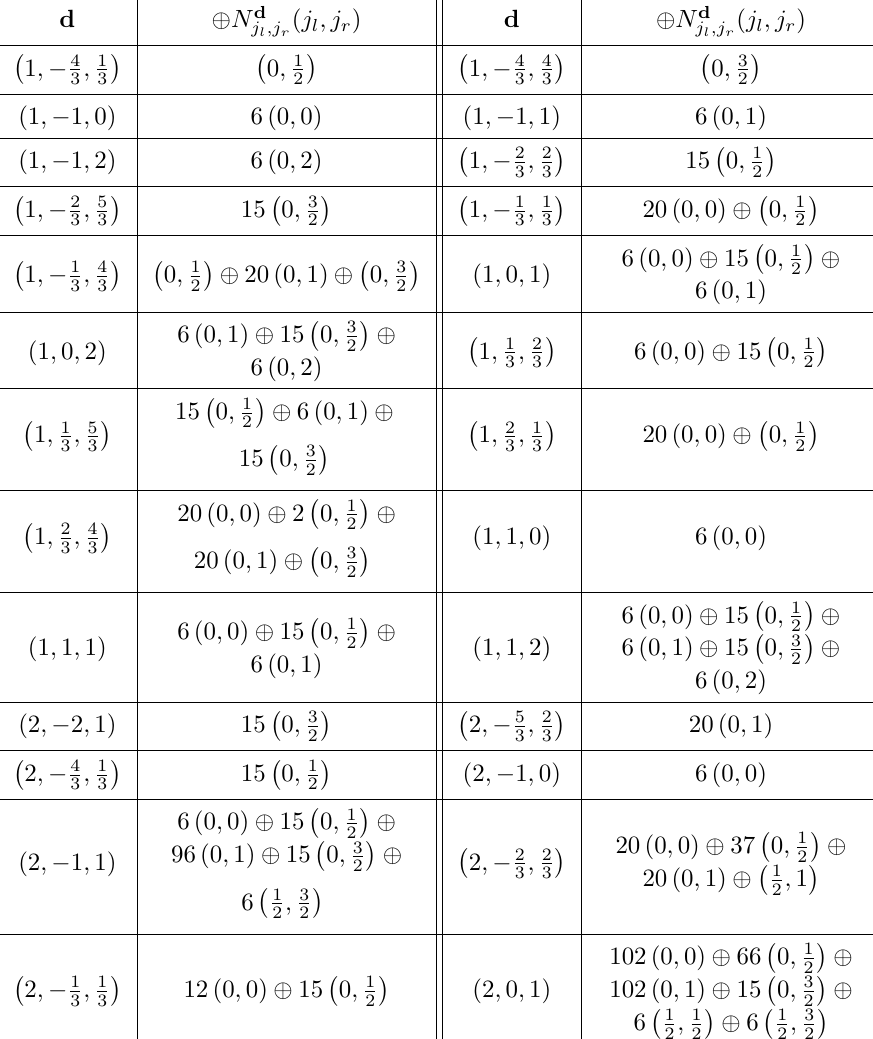
Table 16. BPS spectrum of the SU(3) 4 + 6 F theory for ( d 1 = 1 , d 2 ≤ 1 , d 3 ≤ 2) and ( d 1 = 2 , d 2 ≤ 0 , d 3 ≤ 1) where d = ( d 1 , d 2 , d 3 ) labels the BPS states with charge d 1 m 0 + d 2 α 1 + d 3 α 2 for